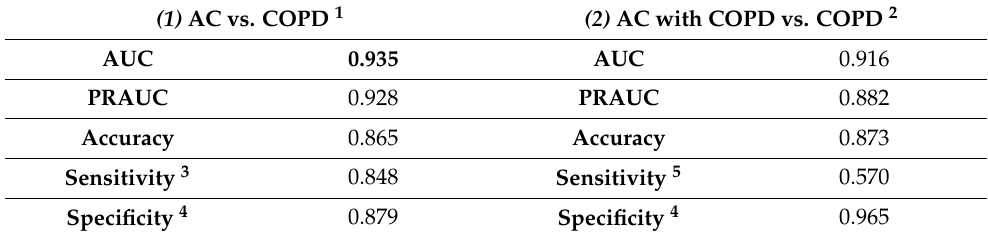
Table 2. Characteristics of random forest classifiers with the highest AUCs *.